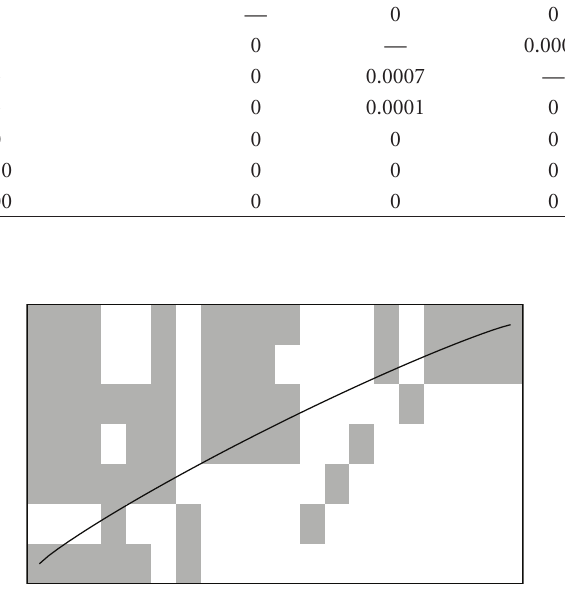
Figure 9: Presence (gray) or absence (white) of the 19 species (columns) in each of the seven forest patches (rows). For nested pattern, all species should appear above the curve. The result shows that species composition was not